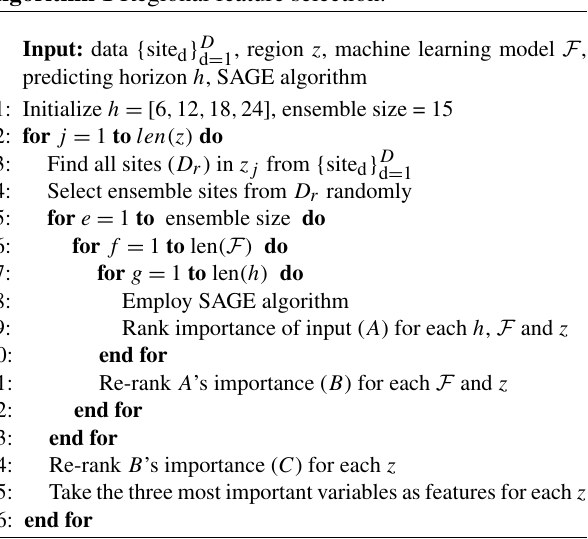
Algorithm 1 Regional feature